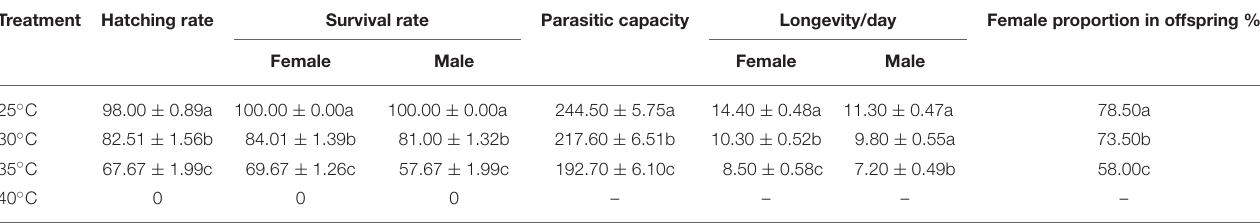
TABLE 1 | The hatching rate, survival rate, parasitic capacity, longevity and female proportion in offsprings of A. gifuensis in response to thermal stress. Treatment Hatching rate